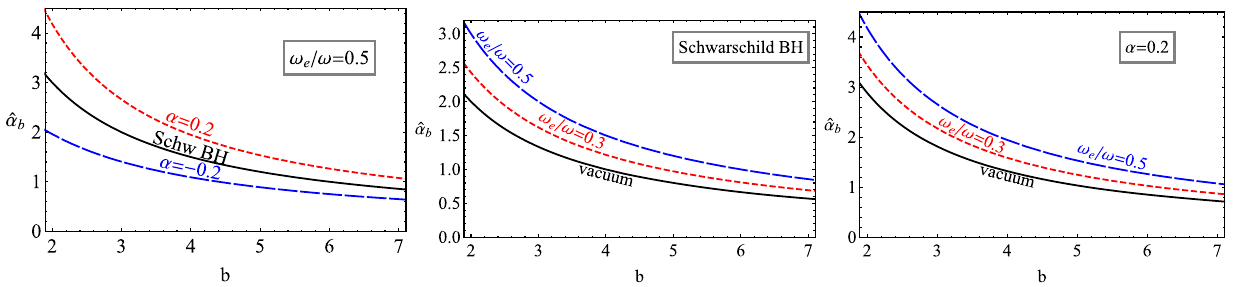
one is for the Schwarzschild case and the right panel is for the fixed value of the MOG parameter α = 0 . 2, respectively